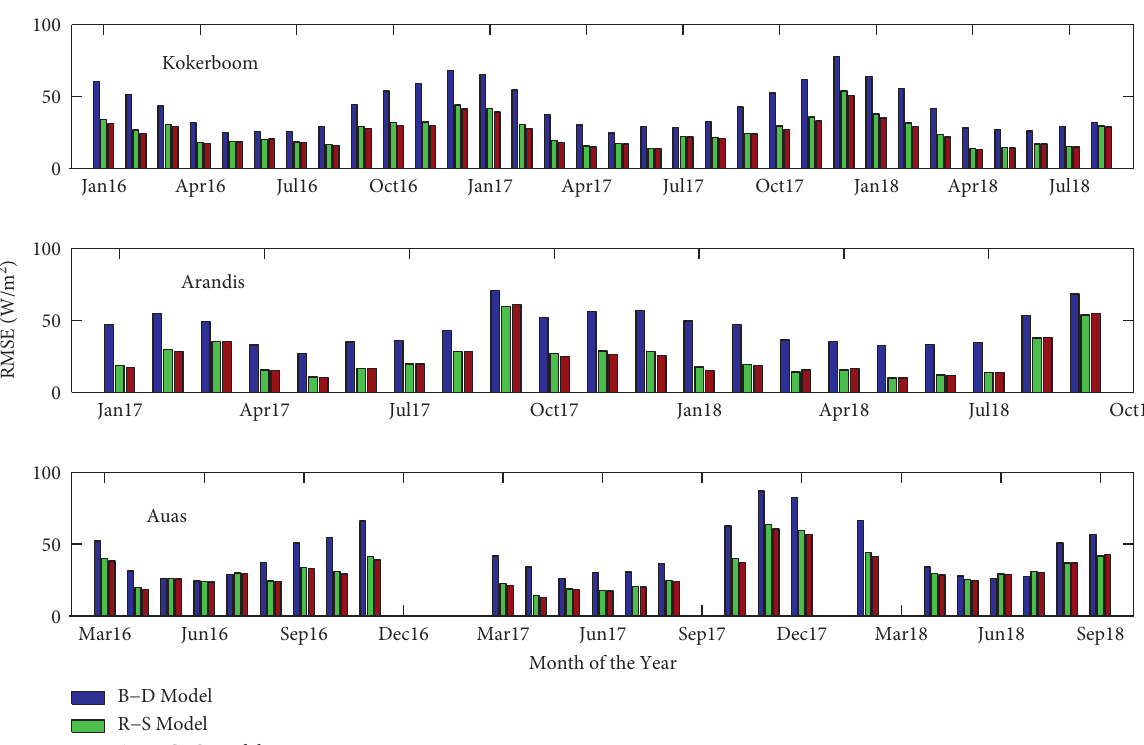
Figure 7: Monthly RMSE values for Kokerboom, Arandis, and